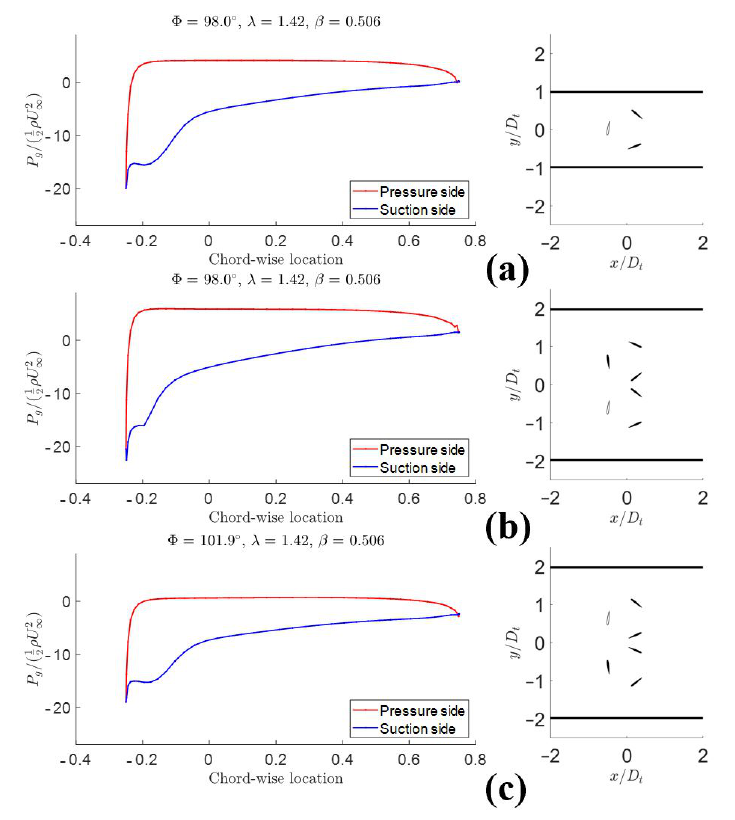
Figure 22. The pressure loading on one of the turbine blades around its maximum torque angle of the 3 configurations: Single turbine ( a ), forward counter-rotating turbines ( b ), and backward counter-rotating turbines ( c ). The relevant blade is colored in white on the right side.